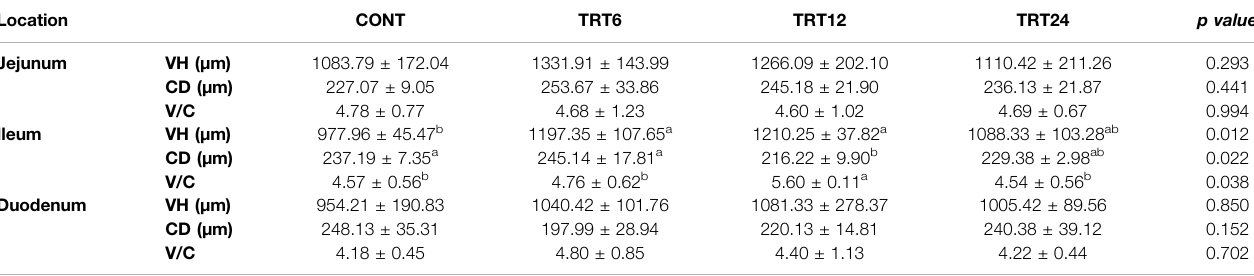
TABLE 9| Effects ofalfalfa-mixed silagefermentation material(AMSFM)onintestinalhistomorphologicalindexesinmeatgeese.Controlgeese(CONT) werefedabasaldiet, whereas TRT6, TRT12, and TRT24 were fed a basal diet supplemented with 6, 12, or 24% AMSFM, respectively. Location CONT TRT6 TRT12 TRT24 p value Jejunum VH ( μ m) 1083.79 ± 172.04